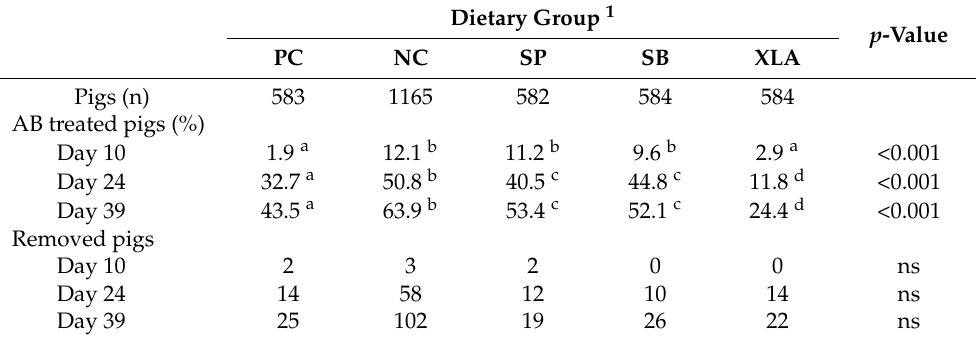
Table 3. Percentage of cumulative antibiotics (AB)-treated pigs and the number of pigs removed from the trial in each of the dietary groups at days 10, 24, and 39 post-weaning. Dietary Group